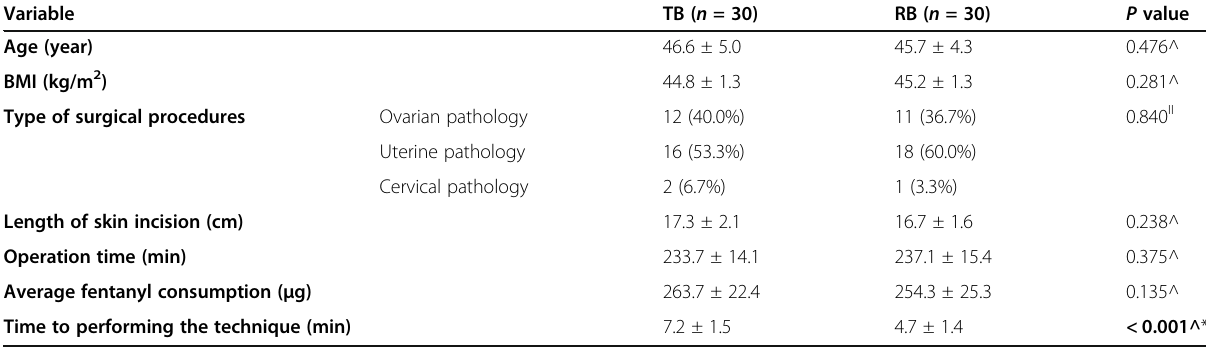
Table 1 Demographic data, operative data, and average fentanyl consumption among the study groups Variable